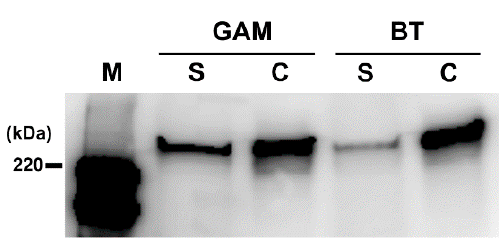
Figure 6. Localization of Toxin A in CD culture. After CD was cultured in the conditioned medium containing PF (2.0 mg/mL) derived from GAM broth or BT, the culture was separated into the supernatant and cell pellet by centrifugation. Toxin A levels in the supernatant (S) and cell pellet (P) were evaluated by Western blotting with anti-Toxin A antibody. M, HRP-labeled protein size marker.